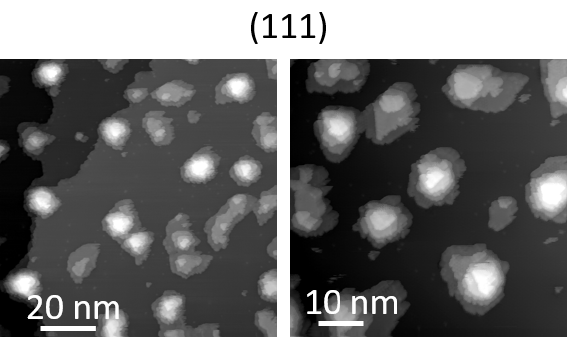
Figure 2. High-resolution in vacuo scanning tunneling microscopy STM micrographs of an ensemble of GaAs QDs sitting on (111)A-oriented AlGaAs substrate.